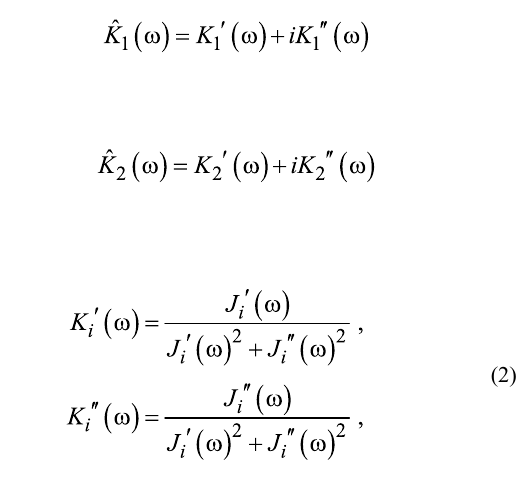
Figure 4: Comparison of the power spectrum density (PSD) of thermal noise in the cantilever-deflection signal before (fine line) and after (thick line) Q-control gain optimization. The peaks in the noise density at the 1st and 2nd resonance modes are suppressed whereas the peaks at the 3rd and 4th modes are enhanced due to the cutoff frequency of 80